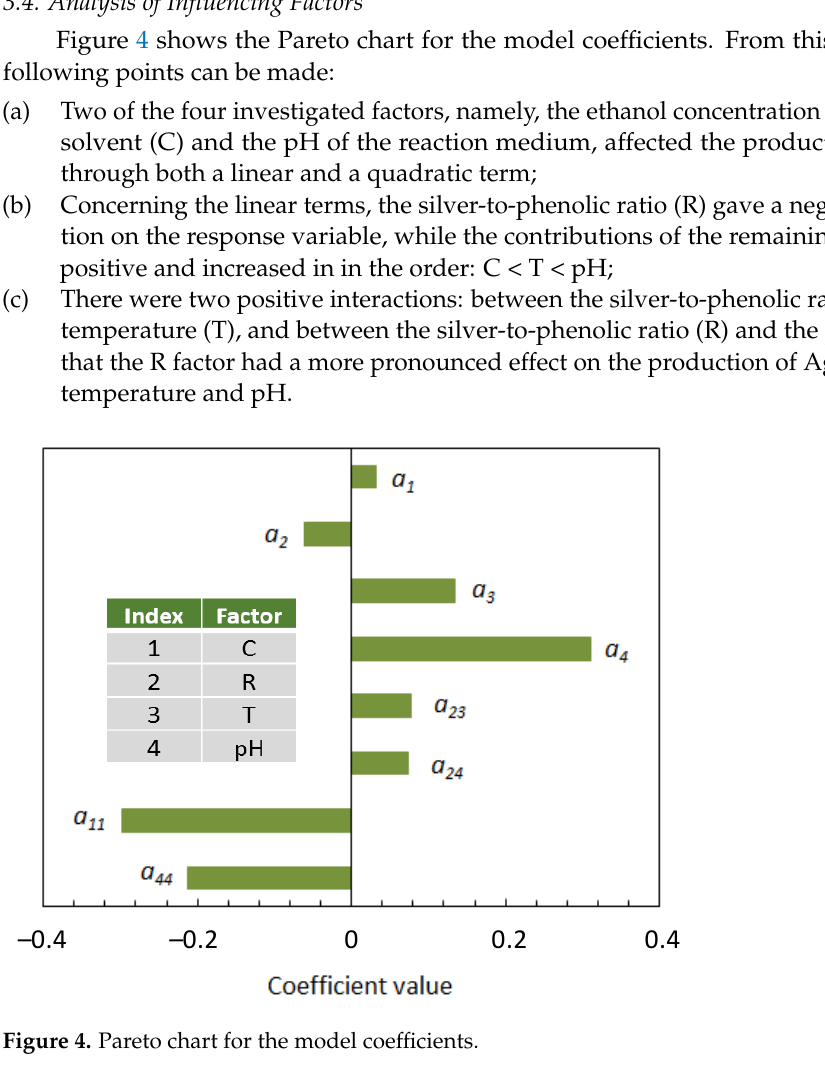
Figure 3. Model residuals as a function of run number.